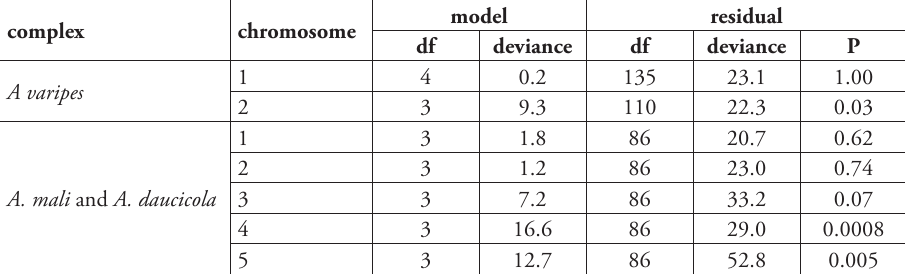
Table 6. Analysis of deviance for differences in centromeric indexes among species of Aphelinus ; acrocen- tric chromosomes were not included in these analyses.